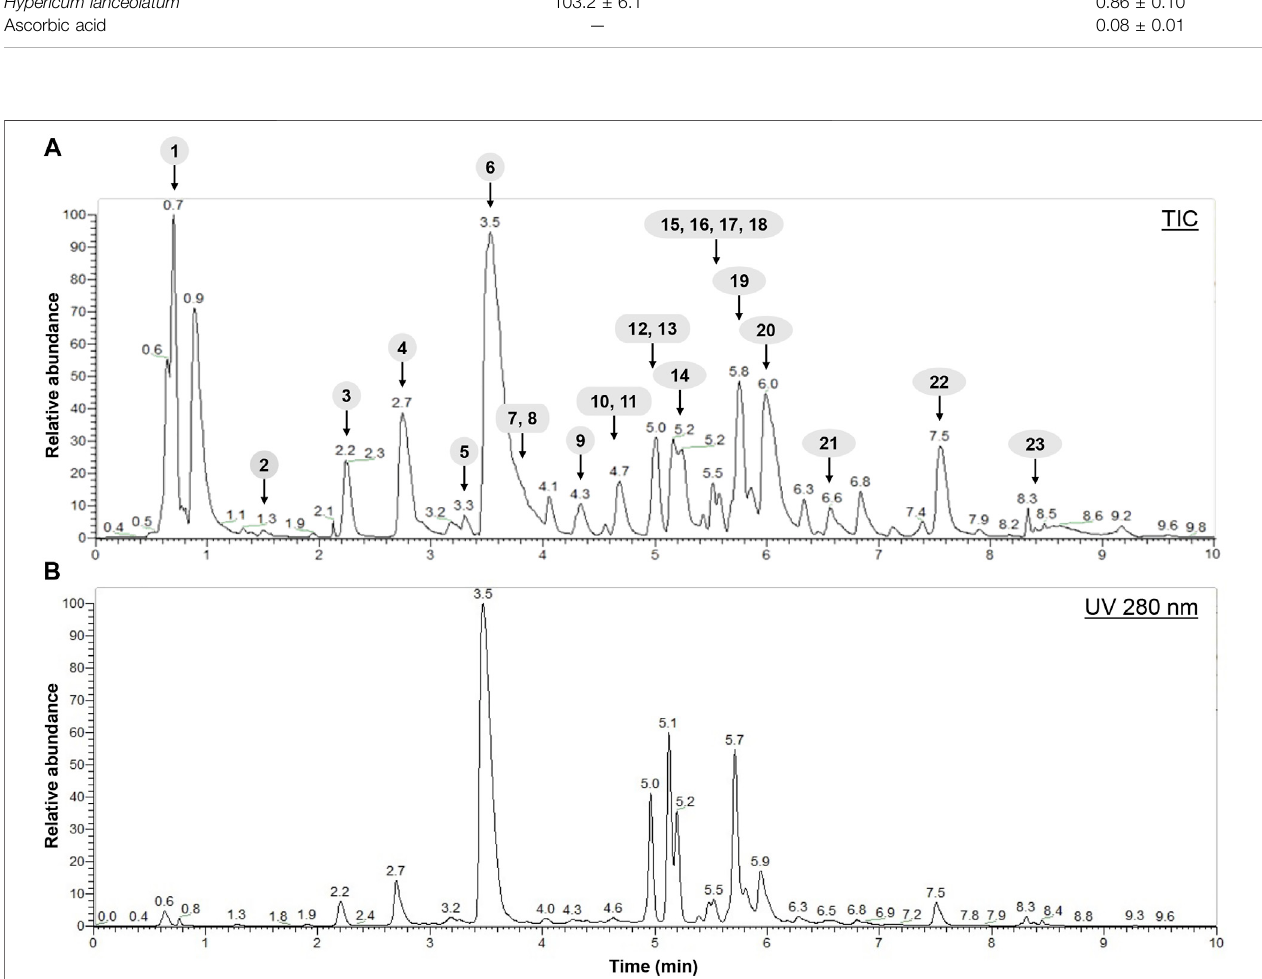
Frontiers in Pharmacology |